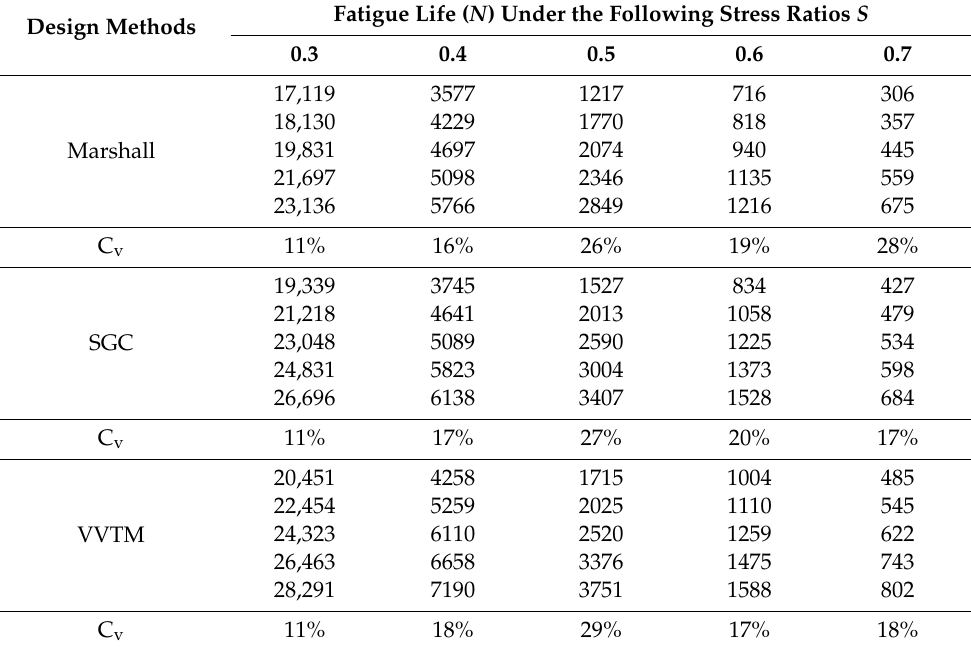
Table 16. Fatigue test results of SMA-13s designed by di ff erent